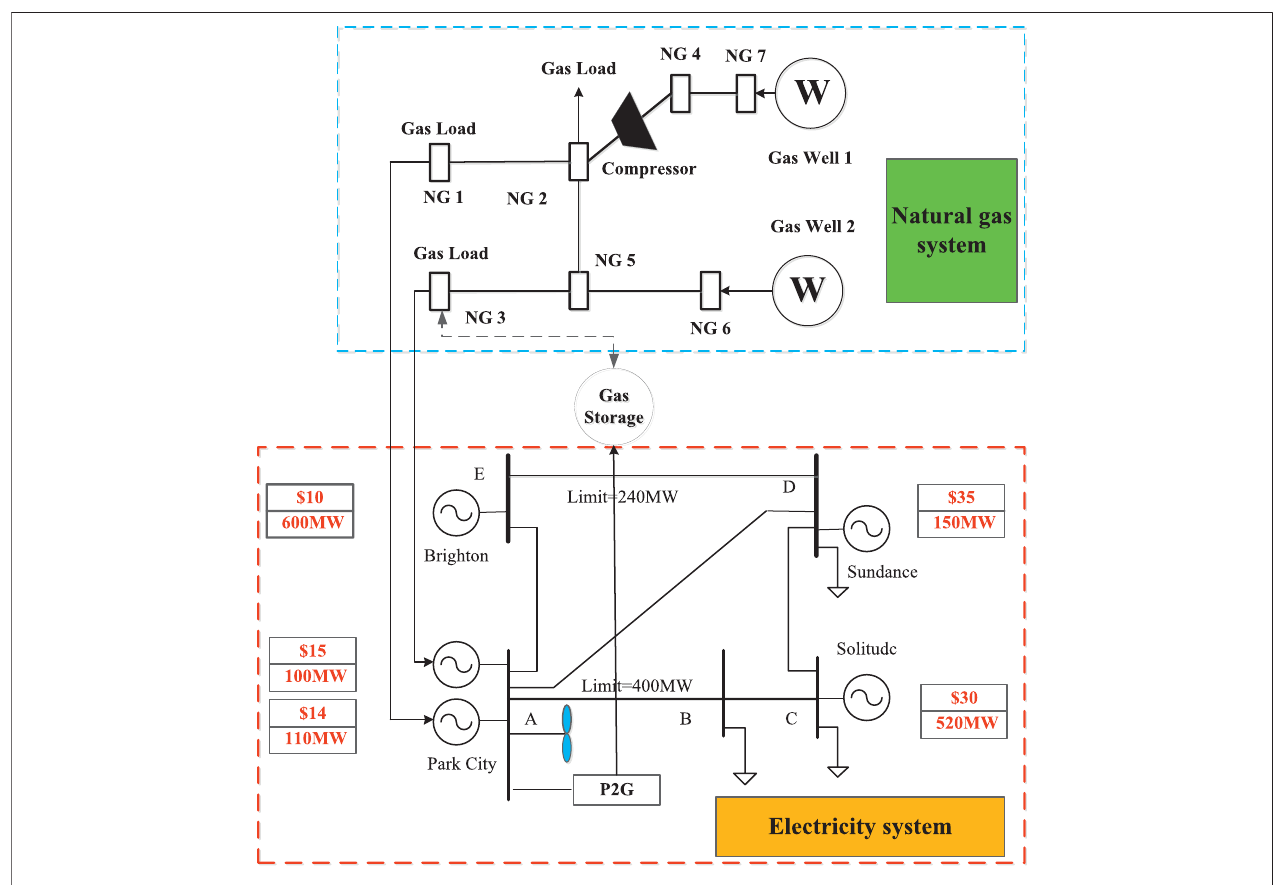
FIGURE 2 | Structure of integrated PJM 5-bus power system and 7-node natural gas